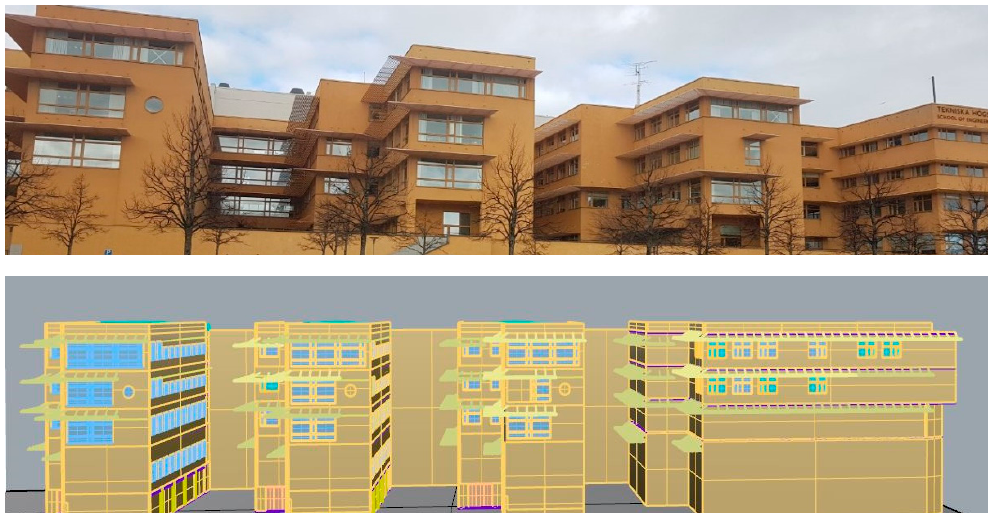
Figure 3. Photo of the real building ( top ) and a 3D render of the building model ( bottom ) showing the south and south-west façades including the permanent overhang. Note that on this side of the building, the basement level is above the ground.